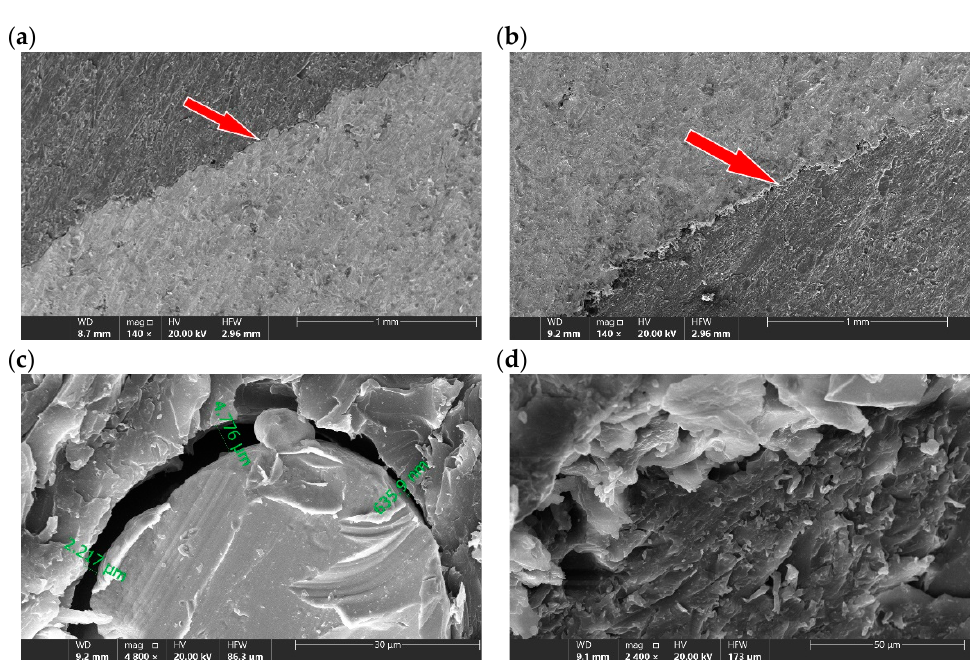
Figure 9. An exemplary view of the raw surface after cutting at the: ( a ) polymer–metal interface, ( b ) metal–polymer interface, ( c ) detail of the polymer–metal interface and the observed gap, and ( d ) detail of the metal–polymer interface.